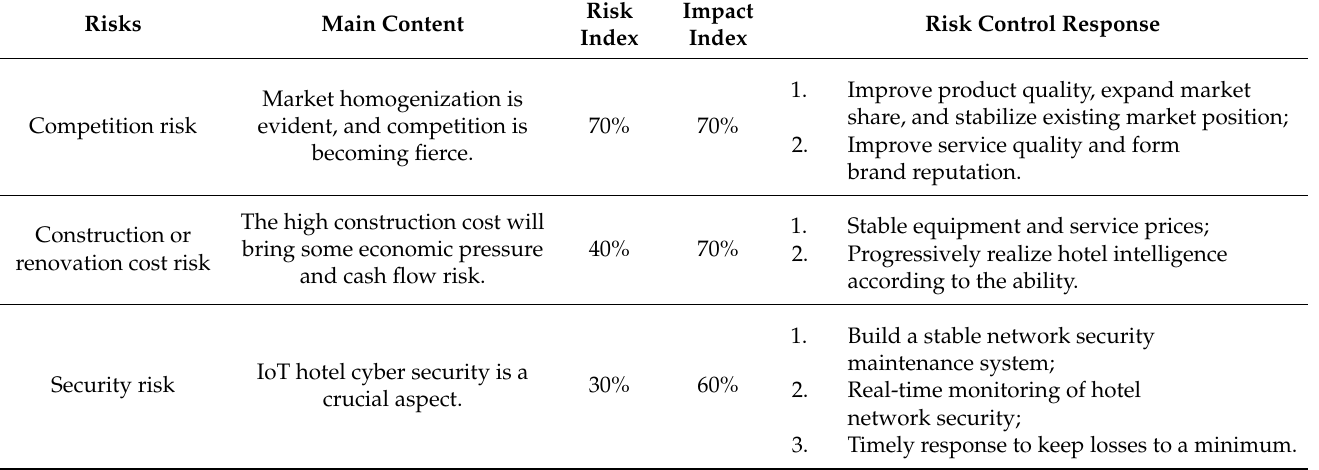
Table 4. The constraints of IoT application development in hospitality industry in